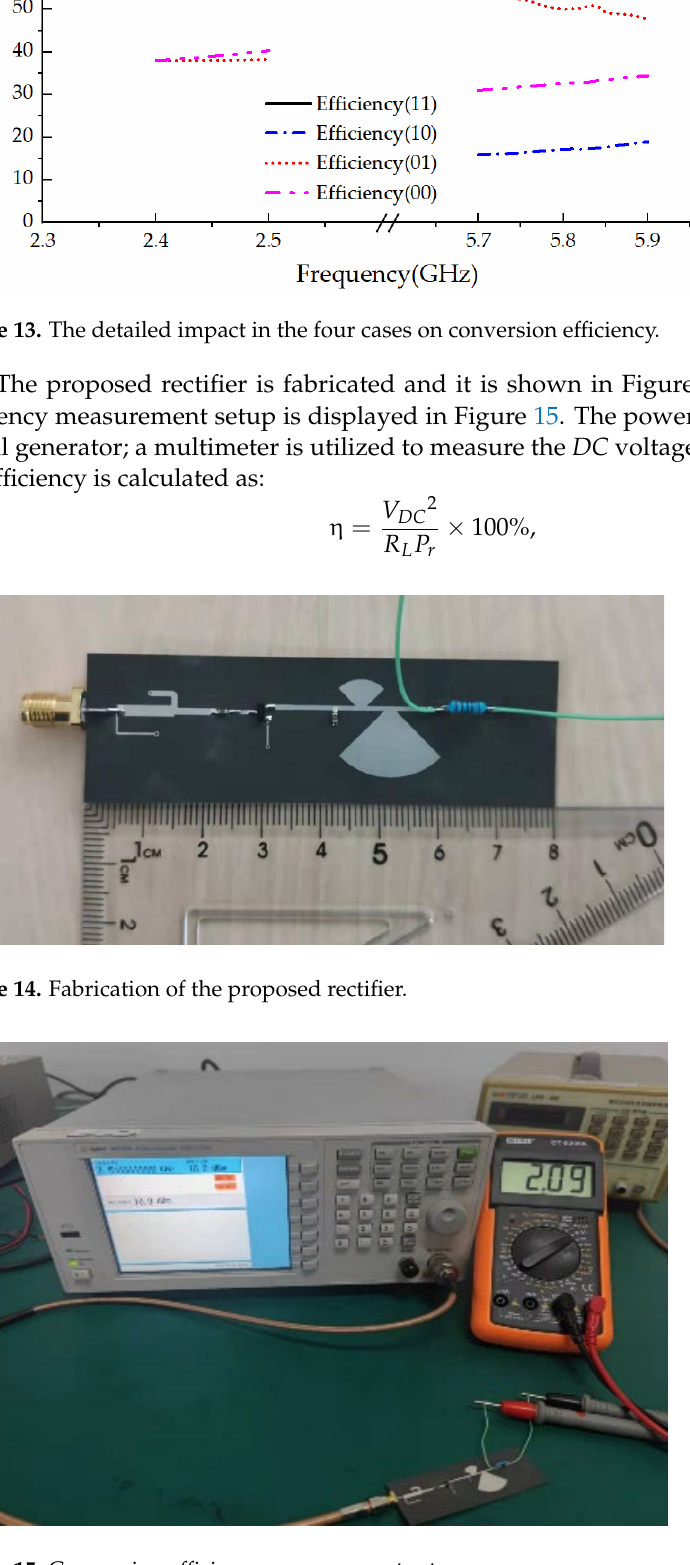
Figure 15. Conversion efficiency measurement setups.